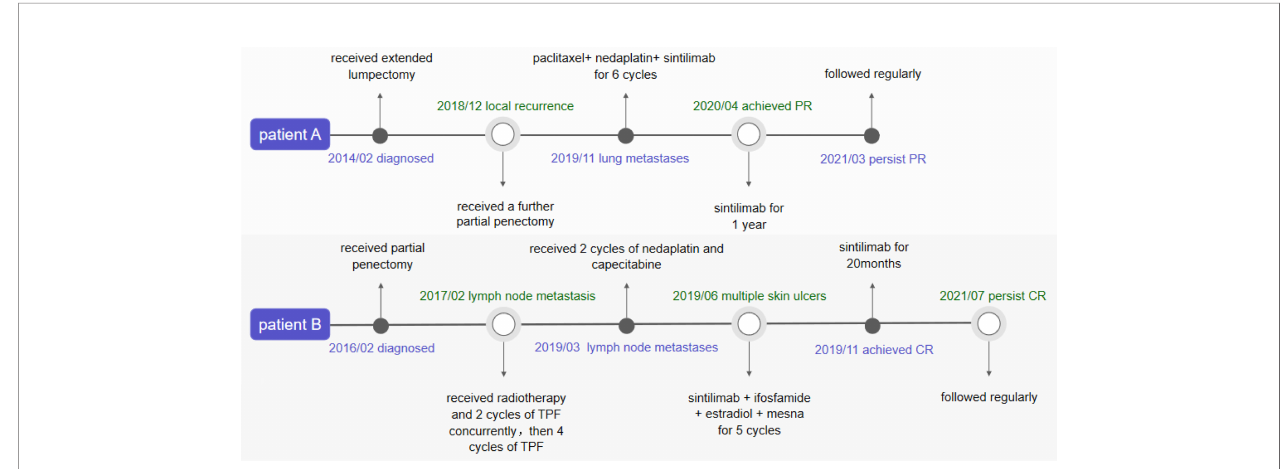
FIGURE 1 | Timeline of the two patients ’ s therapy and effect of